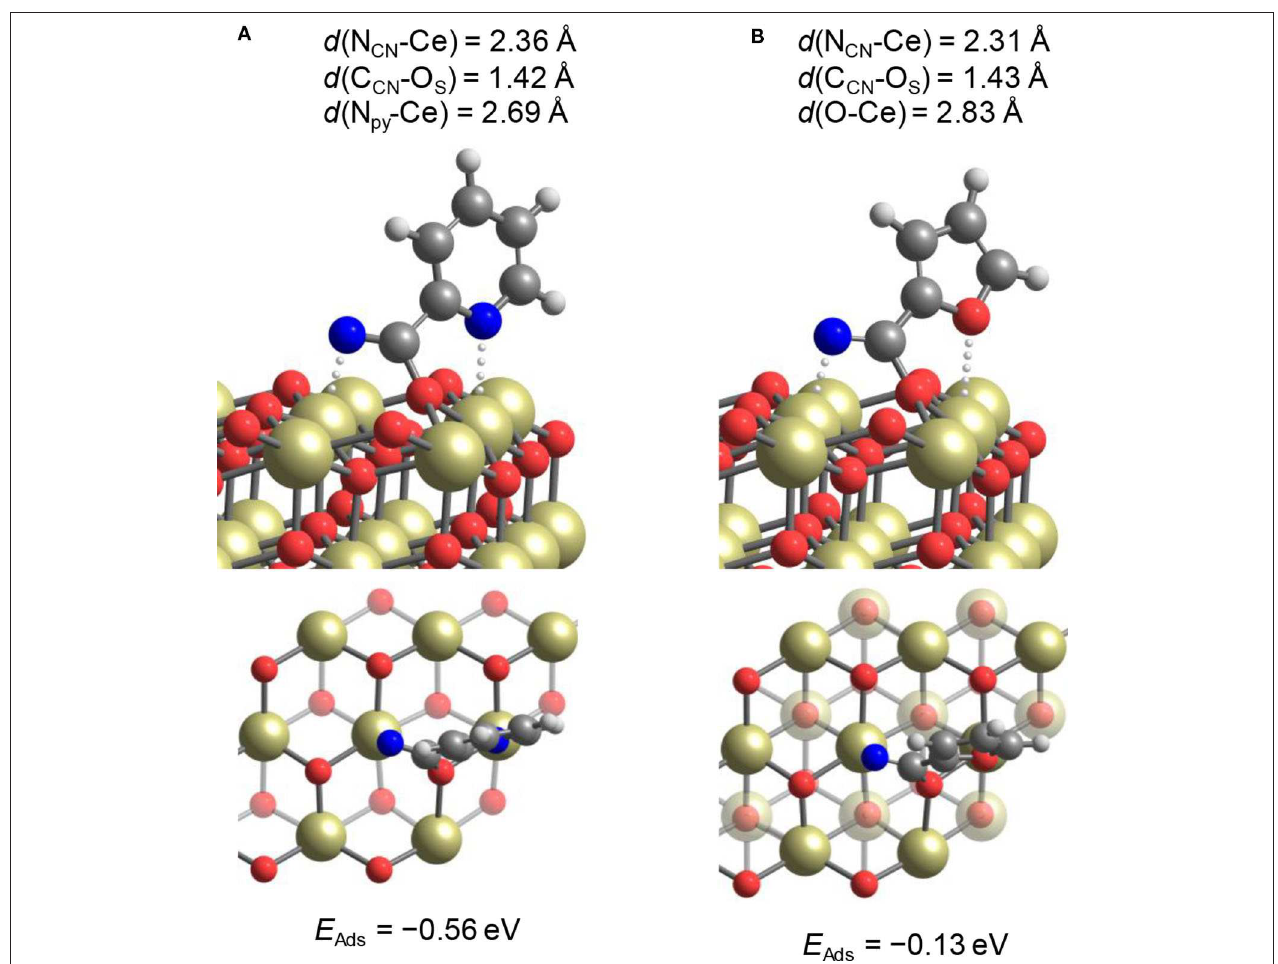
FIGURE 1 | Adsorption structures of (A) 2-cyanopyridine and (B) 2-furonitrile on the CeO 2 (111) surface (Gu et al., 2019b). (Reprint with permission by American Chemical Society). The atoms are color coded as follows: gray, H; dark gray, C; blue, N; red O; dark yellow, Ce.